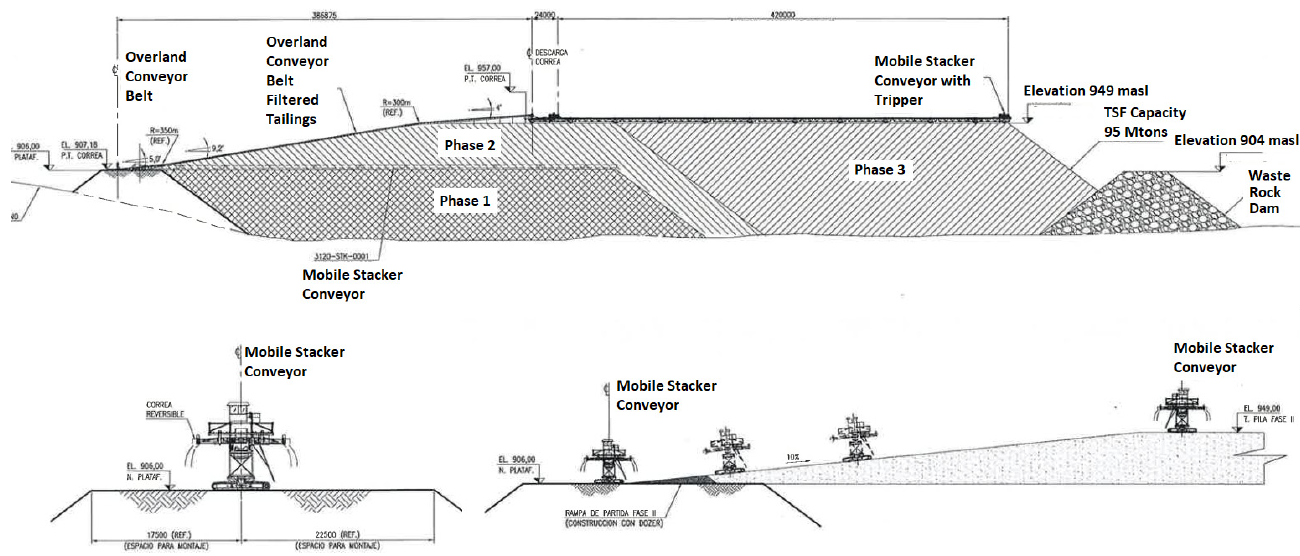
Figure 24. El Espino Mobile Stacker Conveyor with Tripper–Typical Cross Section [51,52,60].